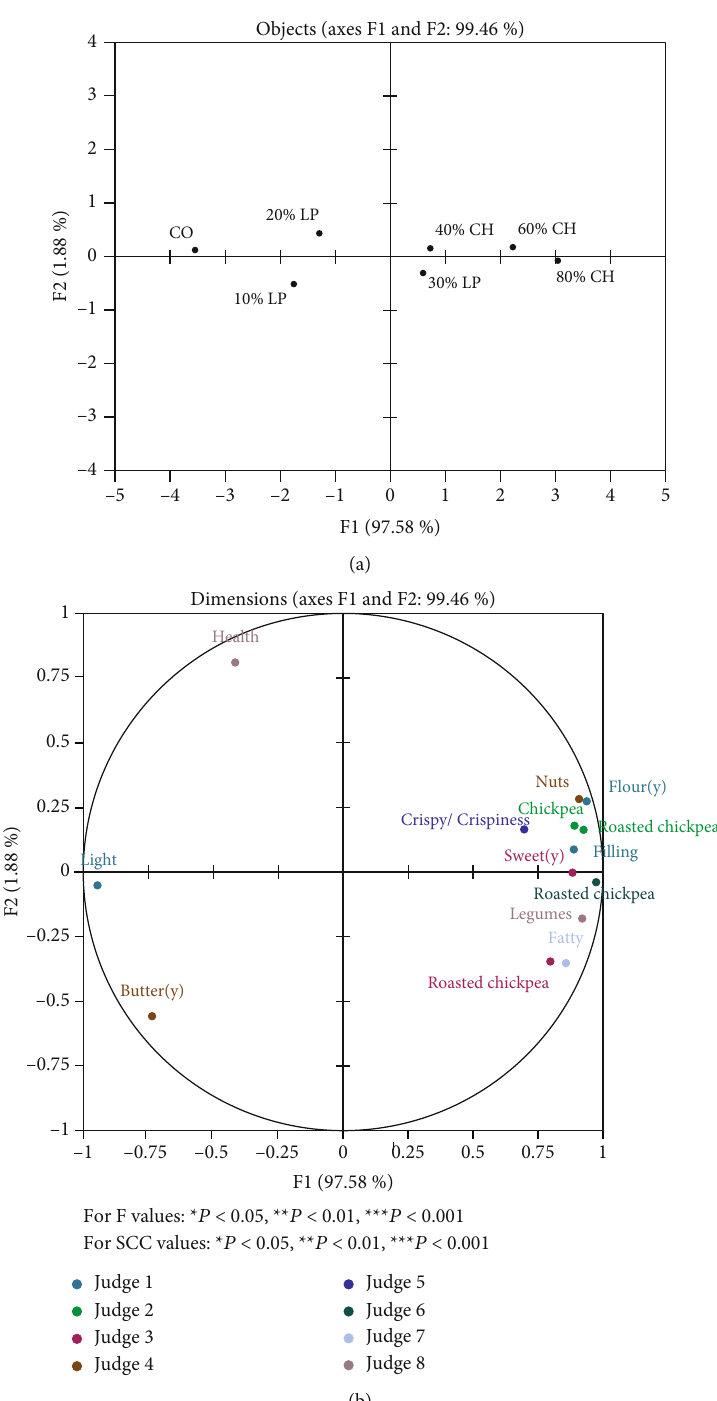
Figure 1: Generalized Procrustes Analysis (GPA) of Greek judge ’ s evaluations of seven crackers samples via Flash pro fi le analysis (a) and variable plot (b). Only attributes generated by judges with good repeatability and ability of discrimination were included. For F values: ∗ P < 0 : 05 , ∗∗ P < 0 : 01 , ∗∗∗ P < 0 : 001 . For SCC values: ∗ P < 0 : 05 , ∗∗ P < 0 : 01 , ∗∗∗ P < 0 : 001